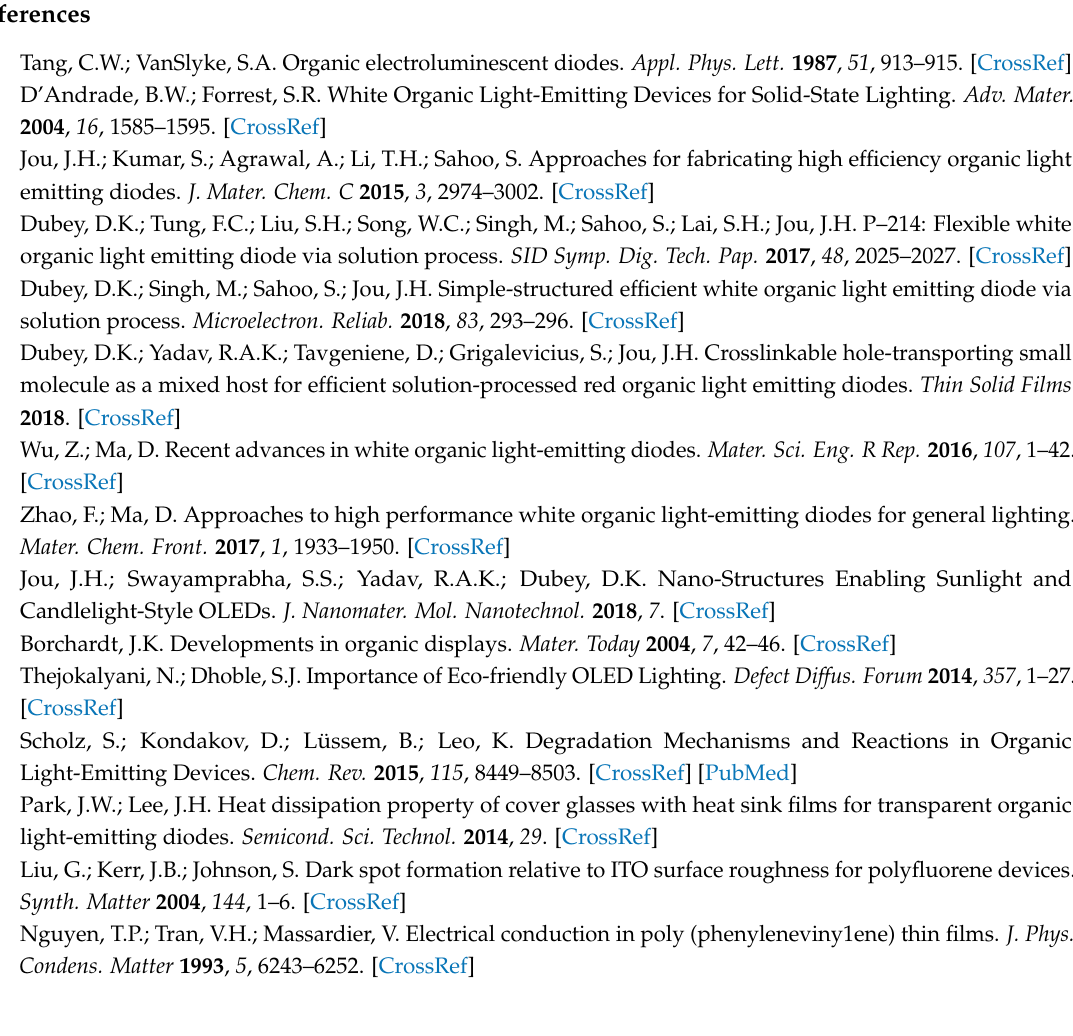
Figure S1: 1 H NMR analysis of 4,4 (cid:48) -Bis(9-carbazolyl)-1,1 (cid:48) -biphenyl,4,4- N , N (cid:48) -Dicarbazole-1,1 (cid:48) biphenyl (CBP). Figure S2: 1 H NMR analysis of 4,7-Diphenyl-1,10-phenanthroline